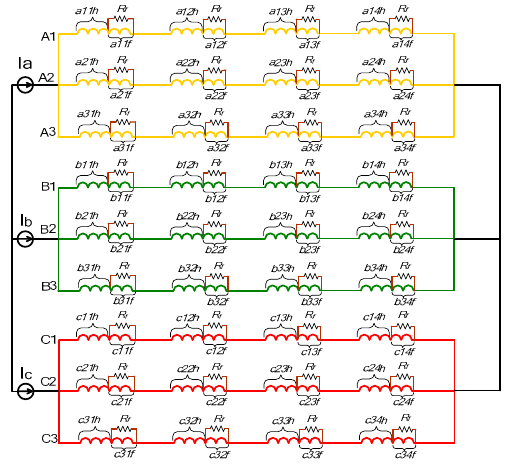
Figure 6. The stator circuit schematic with ITSF in multiple branches.